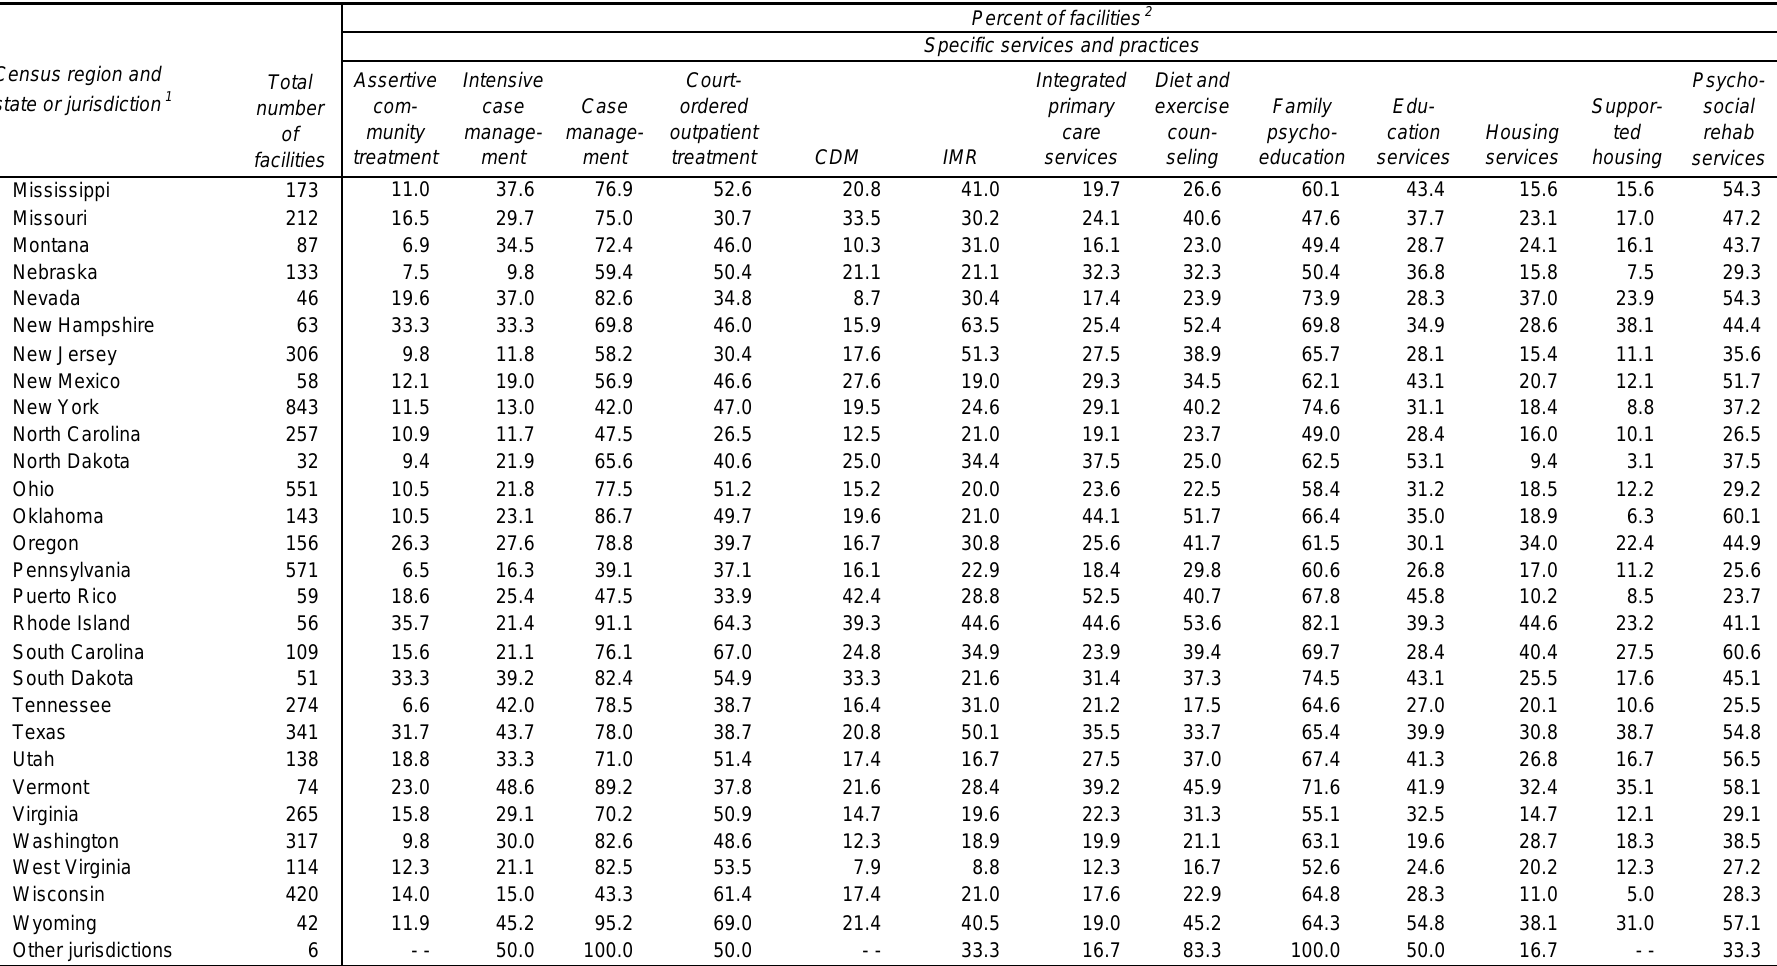
Continued. See notes at end of